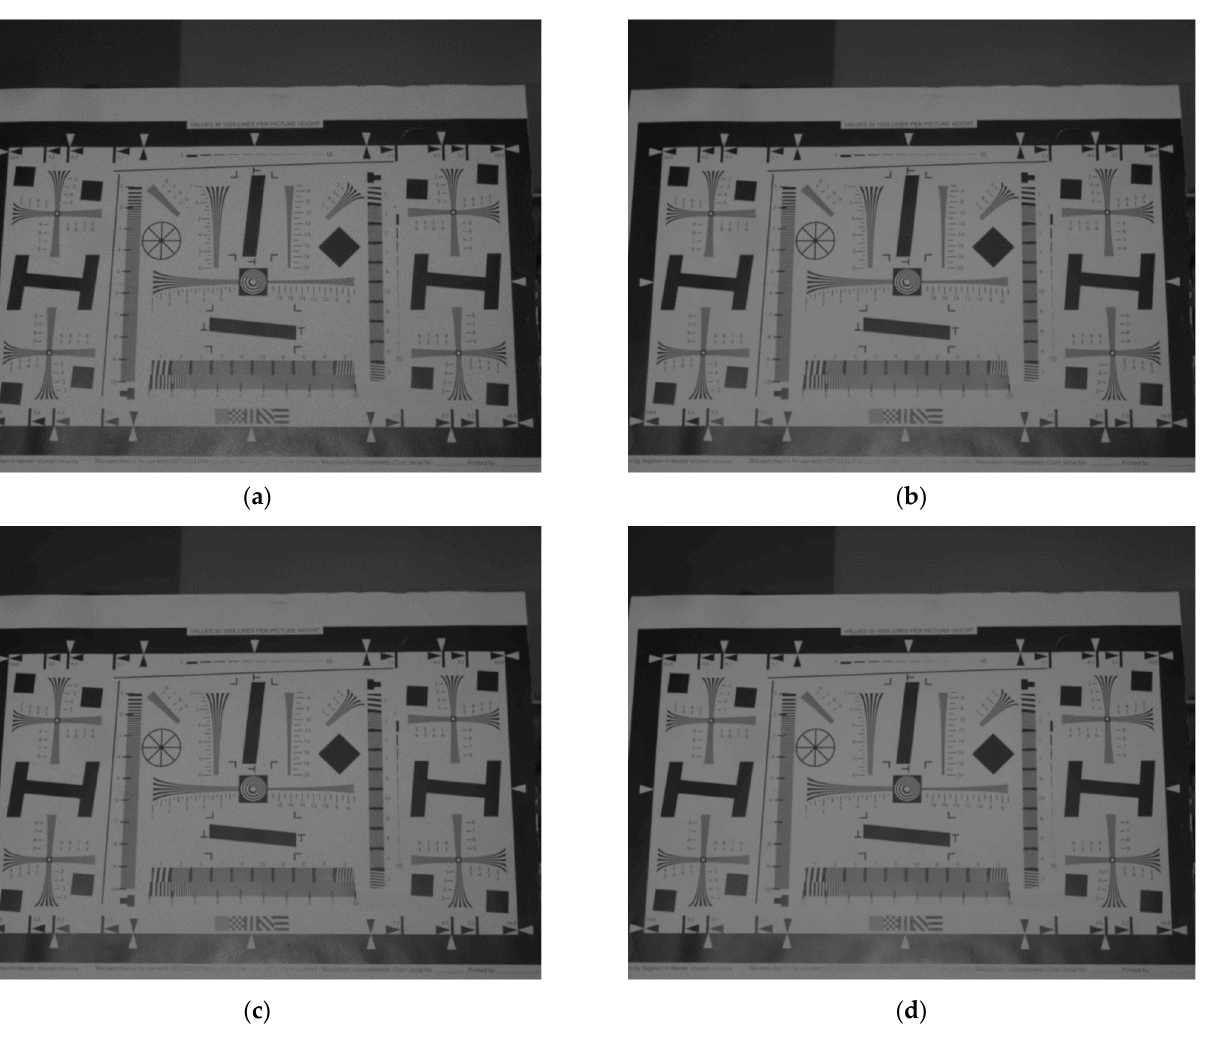
Figure 10. Comparison results of several images: ( a ) original laser image with speckle noise; ( b ) non- local mean filter image; ( c ) improved non-local mean filter image; ( d ) improved weighted non-local mean filter